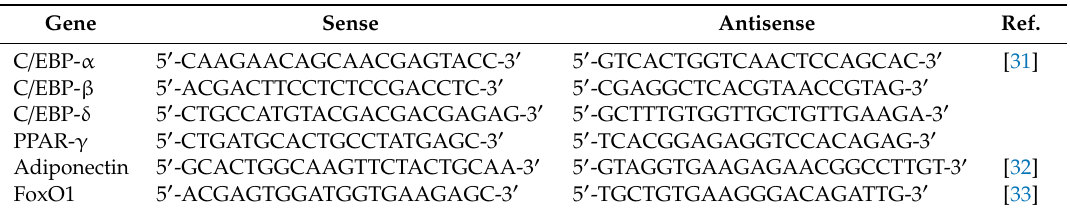
Table 1. Primer sequences for